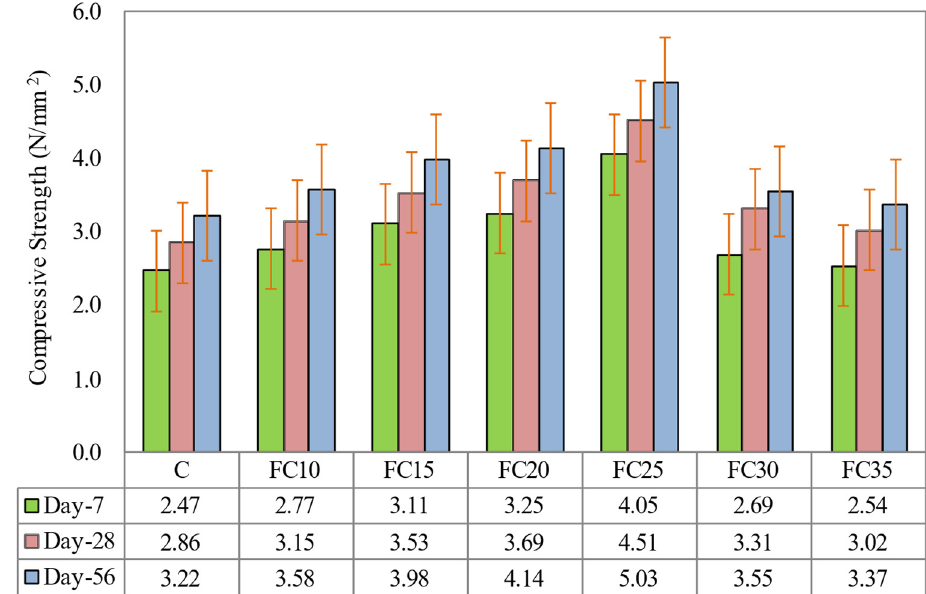
Figure 8. Influence of different weight fractions on compressive strength of LFC.